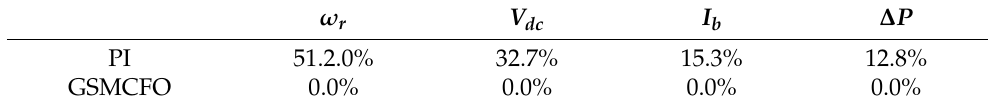
Table 5. Overshoot comparison between the PI controller and